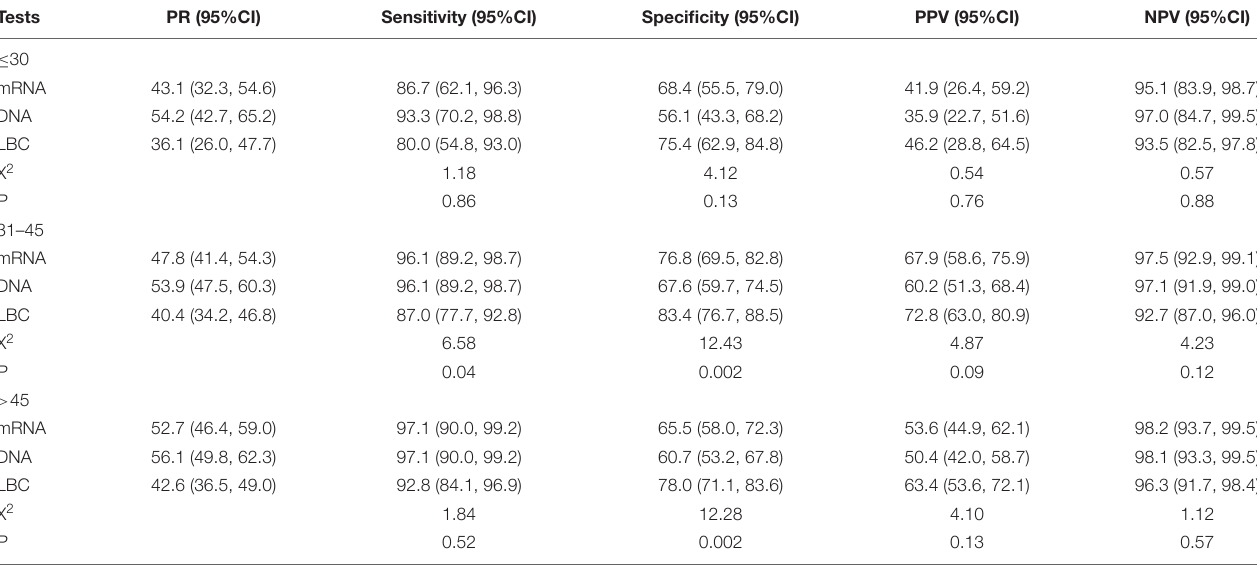
TABLE 5 | The positive rates and clinical performance of tests to detect CIN3 + in different age